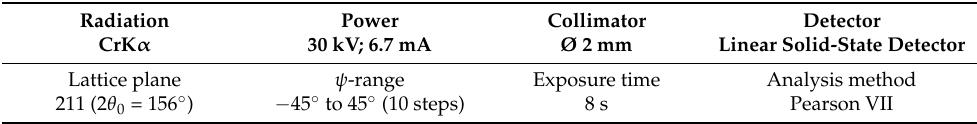
Table 4. Experimental details for the X-ray diffraction.